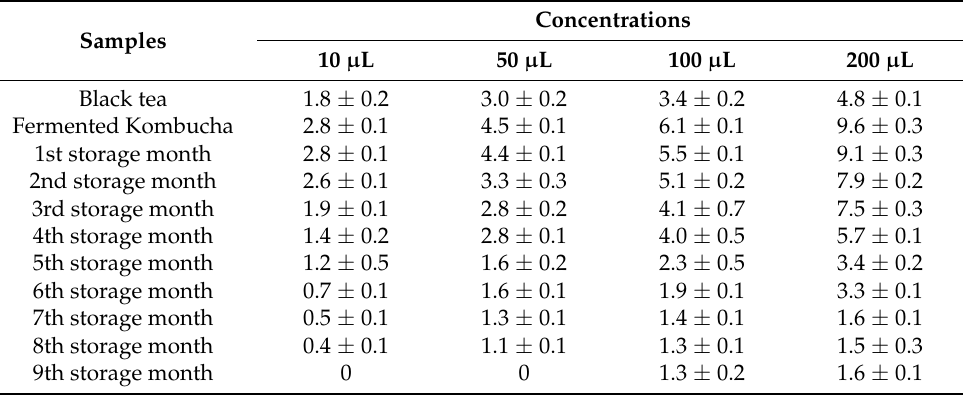
Figure 7. %I ABTS of Trolox, black tea, kombucha tea after 30 days of fermentation and all the samples during storage. White bar (month 1) refers to %I ABTS of kombucha tea after 30 days of fermentation (control), the others refer to kombucha samples over nine months of storage. Asterisks on the bars indicate that mean values were statistically different from the control (* p < 0.05, **** p < 0.0001). Table 3. Trolox equivalent antioxidant capacity (TEAC) values (µg TE mL −1 ) of different samples against ABTS.